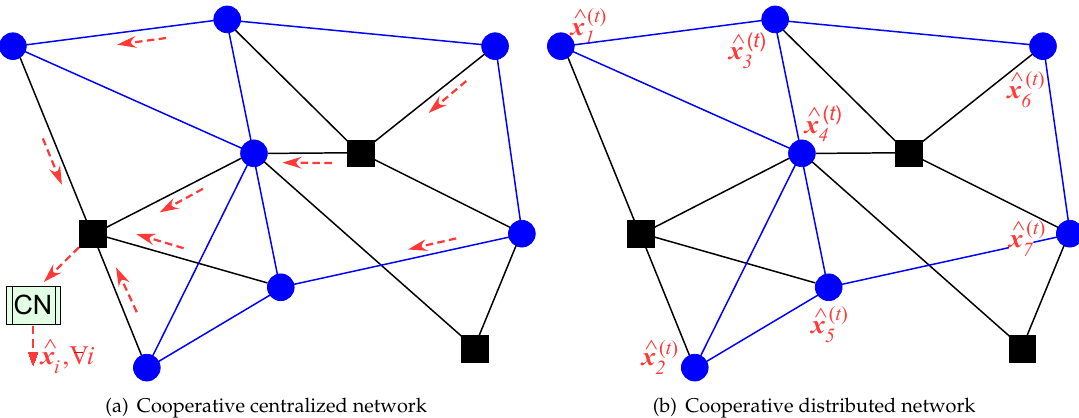
Figure 3. Illustration of different network types based on the type of processing. CN = central node.